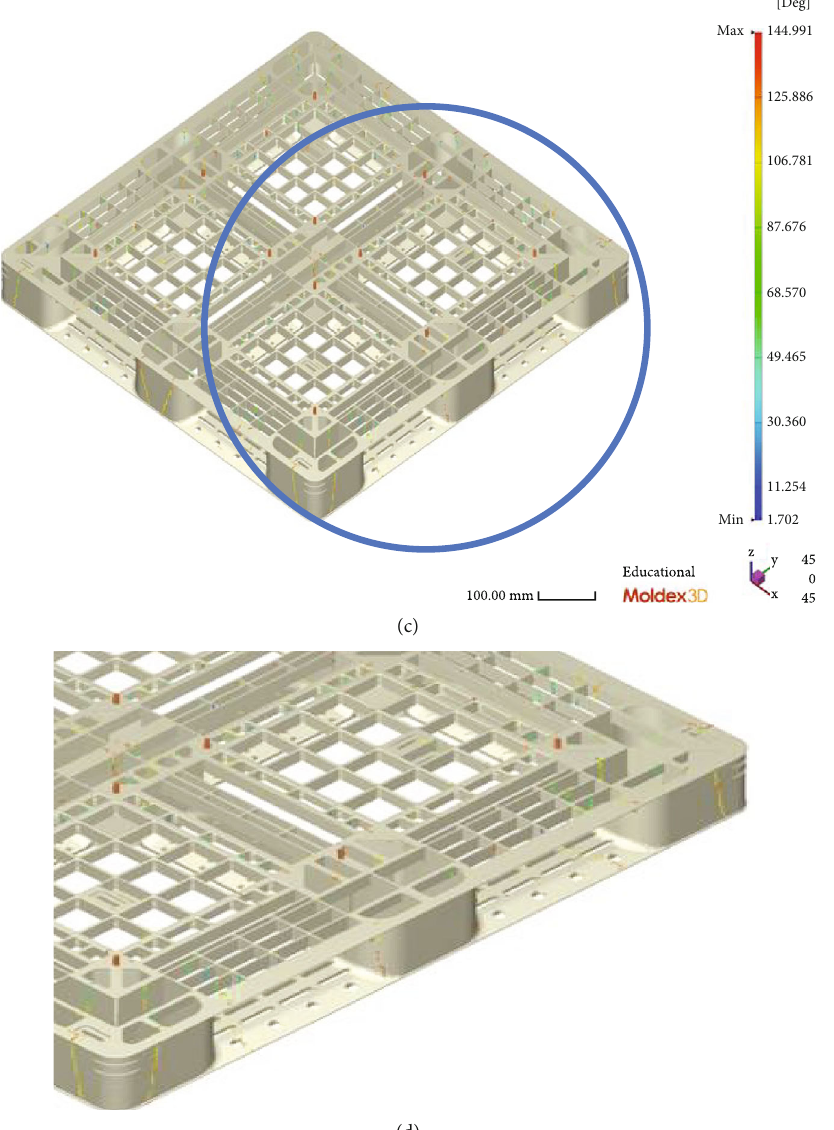
Figure 8: Welding angle. (a) Concurrent valve gate opening scheme ( avg : angle = 85 : 7 ° ). (b) Meeting angle of weld line of pallet by concurrent valve gate opening scheme. (c) Sequential gate opening scheme ( avg : angle = 92 : 6 ° ). (d) Meeting angle of weld line of pallet by sequential gate opening